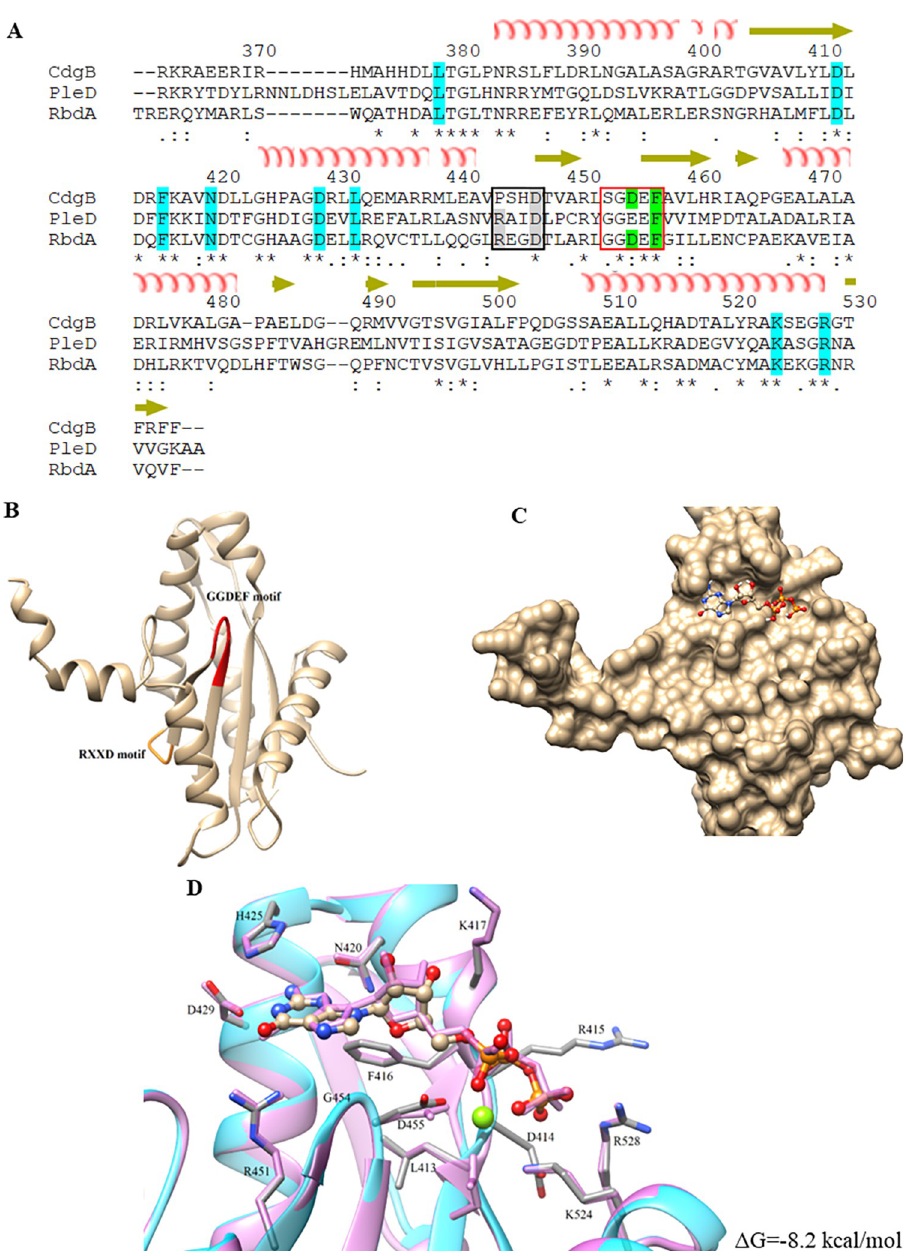
Fig 2. CdgB GGDEF domain structure. (A) Sequence alignment between CdgB GGDEF domain from A . baldaniorum Sp245 (GenBank access number CCD03171.1) and other GGDEF domains of known structure. PleD, C . crescentus (GenBank access number YP_002517919.1), and RbdA, P . aeruginosa (GenBank access number AAG04250.1). Secondary structure elements are displayed above 719 the sequences. The residues highlighted in blue are involved in the interaction with the substrate; in green, those that interact with the cofactor; the active site of the GGDEF motif is highlighted in red square, and the RXXD motif is in black square. (B) Structural model of the CdgB GGDEF monomer generated by homology modeling. The GGDEF motif is highlighted in red and the RXXD pattern is highlighted in orange. (C) Structural model of CdgB GGDEF monomer in complex with GTP. The GGDEF domain is shown in surface mode. (D) Model of the GGDEF/GTP interaction generated by molecular coupling with a Δ G = - 8.2 Kcal/mol and overlapped with the 5XGD crystal structure, corresponding to GGDEF domain from P . aeruginosa showed in light purple color with an RMSD of 0.539 of ligands. The Mg 2+ ion is shown in green.